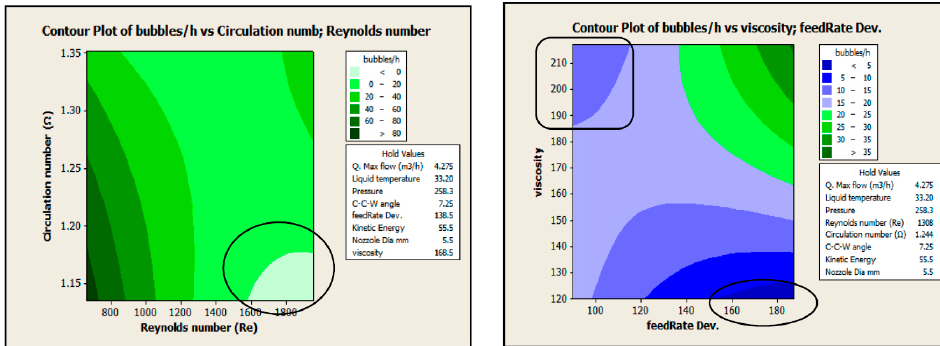
Figure 19. The axis-symmetric waste at different ranges of ( Re ) and Ω .